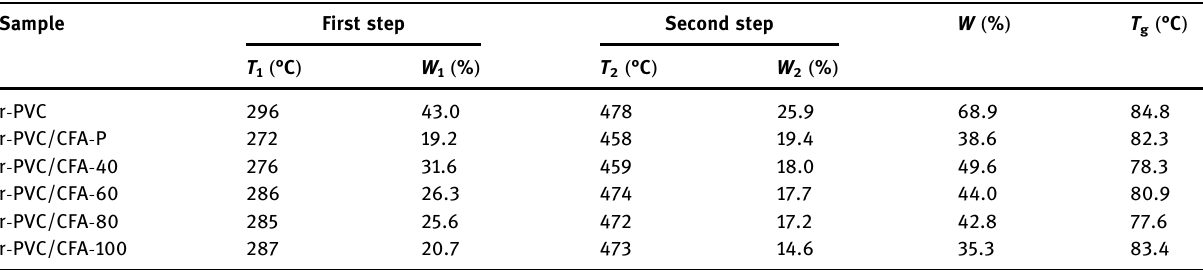
Table 3: Thermal properties of the r - PVC, r - PVC/CFA - P, and r - PVC/CFA composites